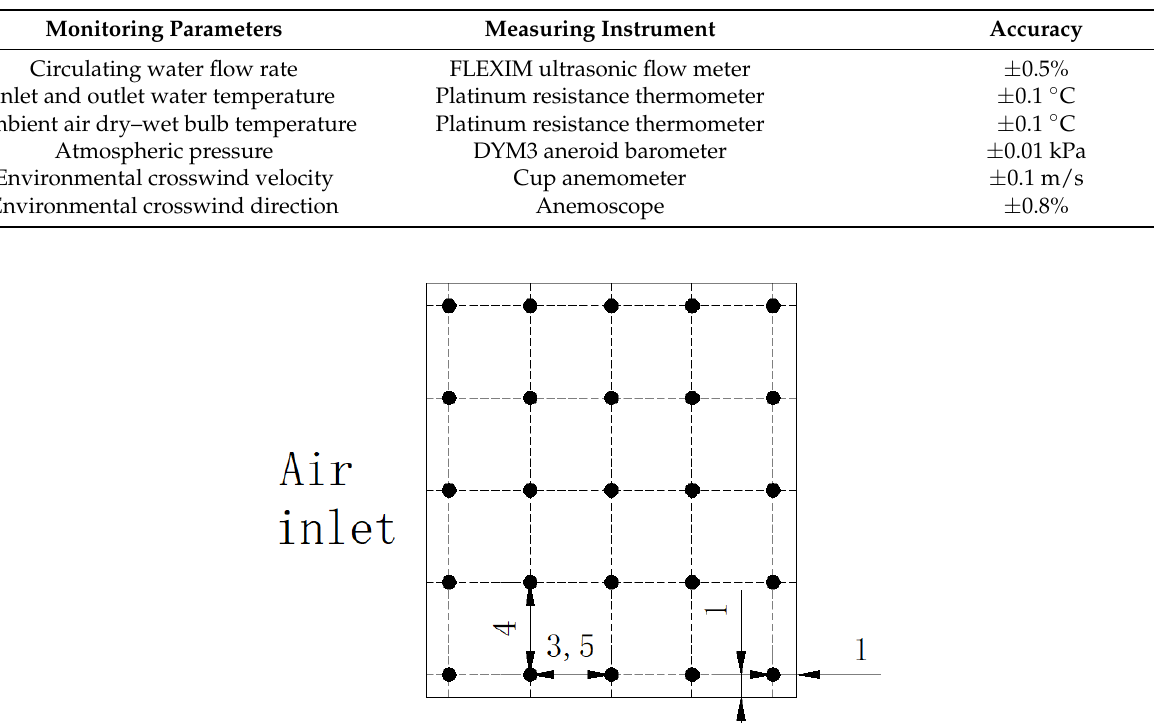
Table 2. Monitoring parameters and corresponding measuring instrument for the measurement.